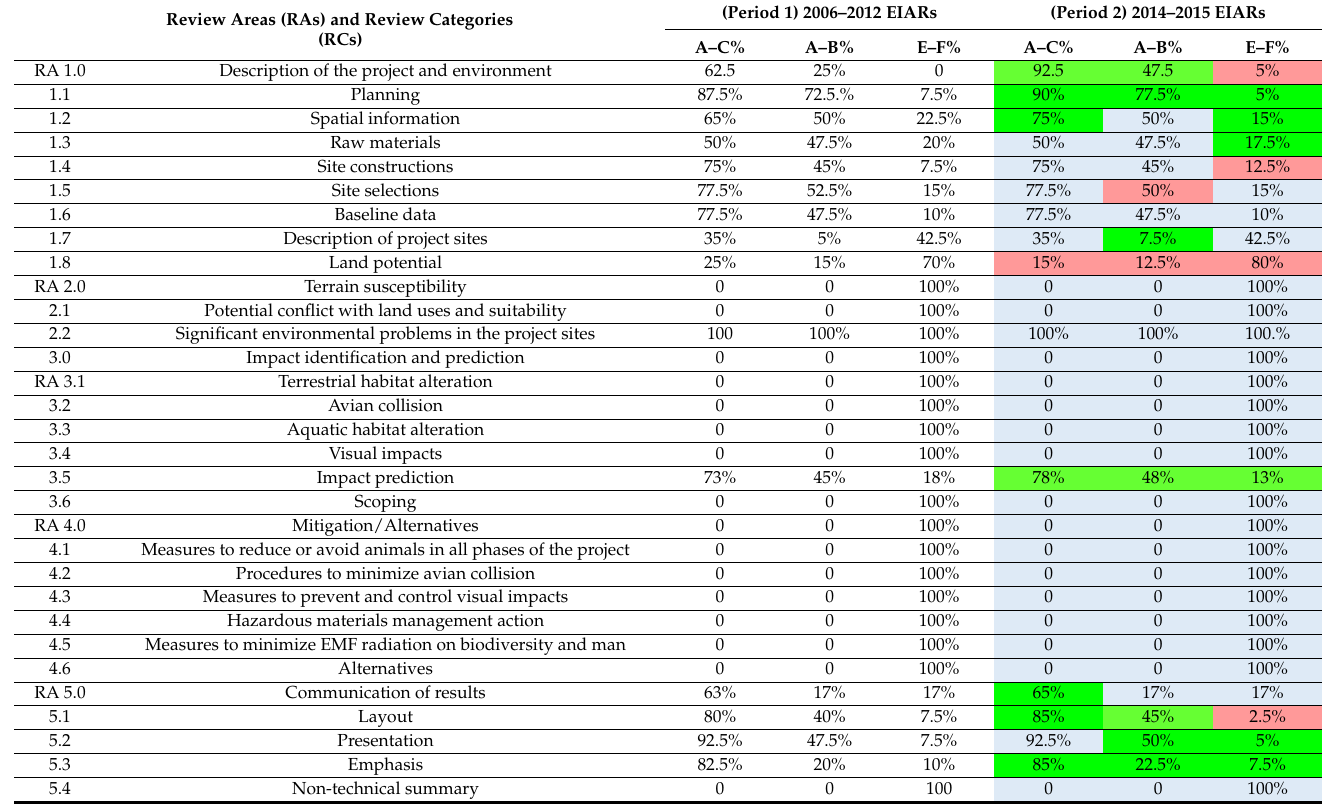
Table 12. Degree of changes in the quality of EIARs between Period 1 and Period